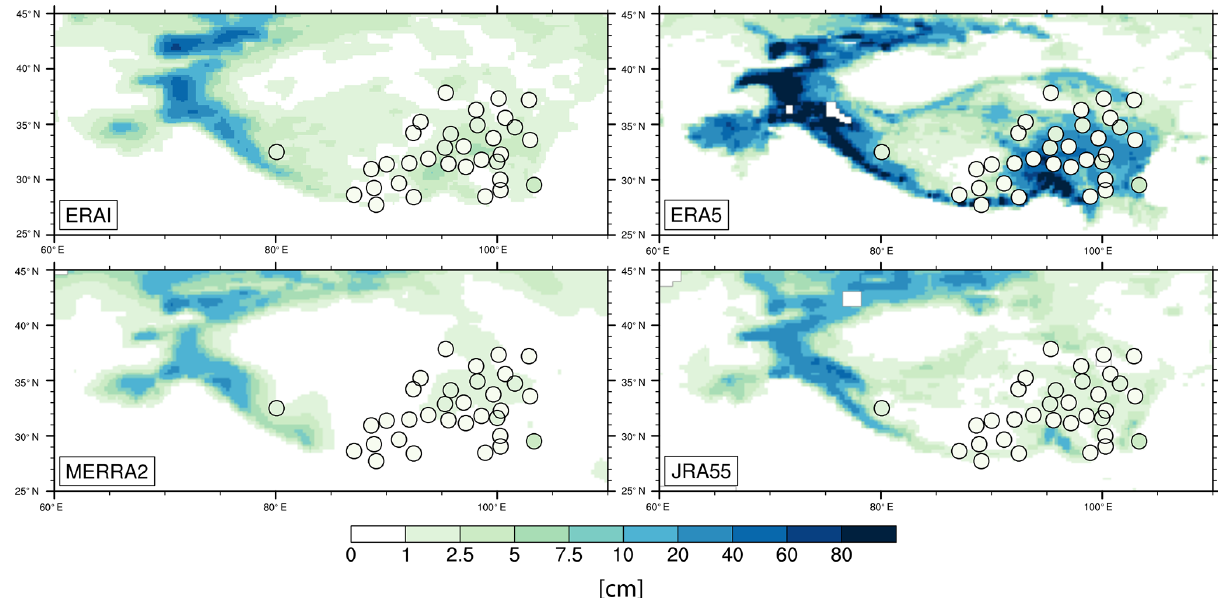
Figure 5. Maps of the 5-year mean SD (in centimetres) over the TP region in January for each of the four reanalyses (ERA5, ERA-I, MERRA-2 and JRA-55) with the in situ SD (in centimetres) embedded locally in each map.